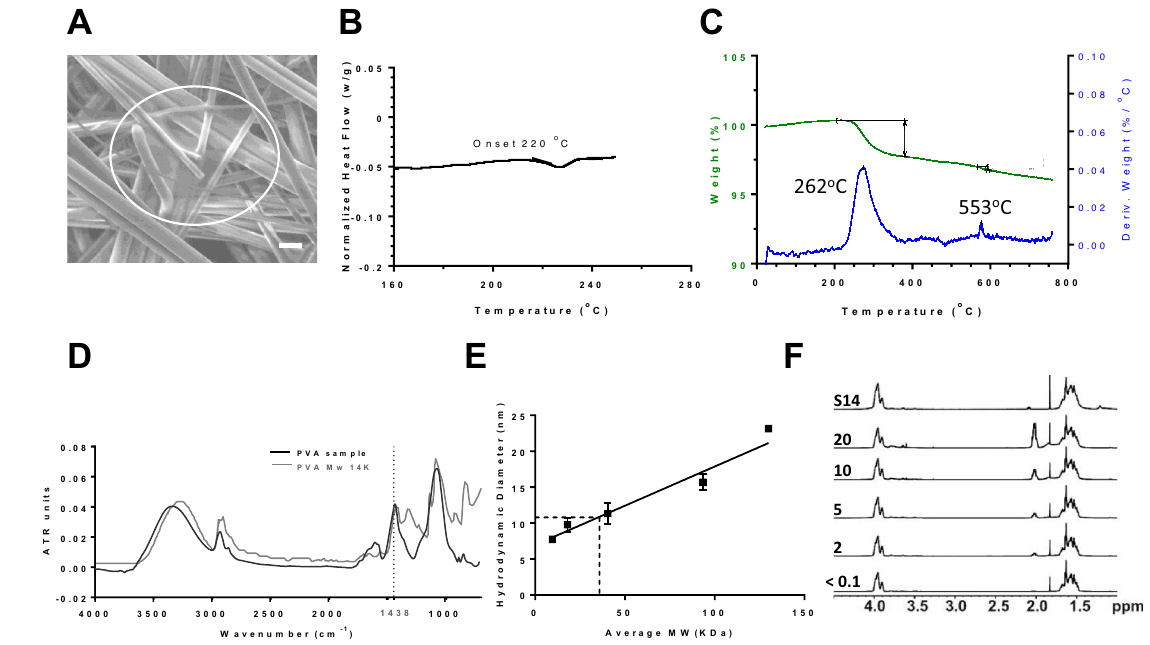
Figure 5. Chemical properties of glass fibre matrix. Panel ( A ) shows a scanning electron microscopy image indicating presence of binder in glass fibre (S14), visible as a film in the white-circled area. Scale bar shows 10 µm. Such areas were relatively sparse, compared to the extensive films apparent in matrices imaged after loading and drying of trehalose:sucrose solution (Fig. 2B). Panel ( B ) shows a differential scanning calorimetry thermogram of glass fibre (S14), representative of duplicate measurements. The graphs show heat flow as a function of temperature during scanning from 40 to 250 °C. Panel ( C ) displays thermogravimetric analysis of glass fibre (S14), showing a thermal decomposition step. Weight losses (green lines) and the rate of weight loss (i.e. derivative, %/°C) (blue lines) are shown. Panel ( D ) shows the sample spectrum obtained from attenuated total reflectance Fourier transform spectroscopy (ATR-FTIR) for the binder recovered from glass fibre (S14) (black), and a reference library spectrum for PVA (grey). Panel ( E ) shows estimation of the molecular weight of the binder extracted from glass fibre (S14) by DLS. Points and solid line show a standard curve generated using PVA of known MW. Dashed lines indicate the hydrodynamic radius of the PVA extracted from S14 (11 nm) and the inferred MW (36 kDa). Points and error bars indicate the mean and range respectively of duplicate DLS measurements. Panel ( F ) shows 1H NMR spectra used to estimate the percentage hydrolysis of the binder extracted from glass fibre (S14). The upper spectrum (labelled S14) is that of the extract, with unknown percentage hydrolysis and hence an unknown percentage of monomers bearing acetyl groups. The five spectra below were obtained using standards prepared by proportionately mixing 80% and 100% hydrolysed PVA to achieve a range of acetyl group content ranging from < 0.1% up to 20% (as per labels to left of panel). The X-axis indicates chemical shift measured in parts per million (ppm), with relative intensity indicated in the Y-axis dimension i.e.